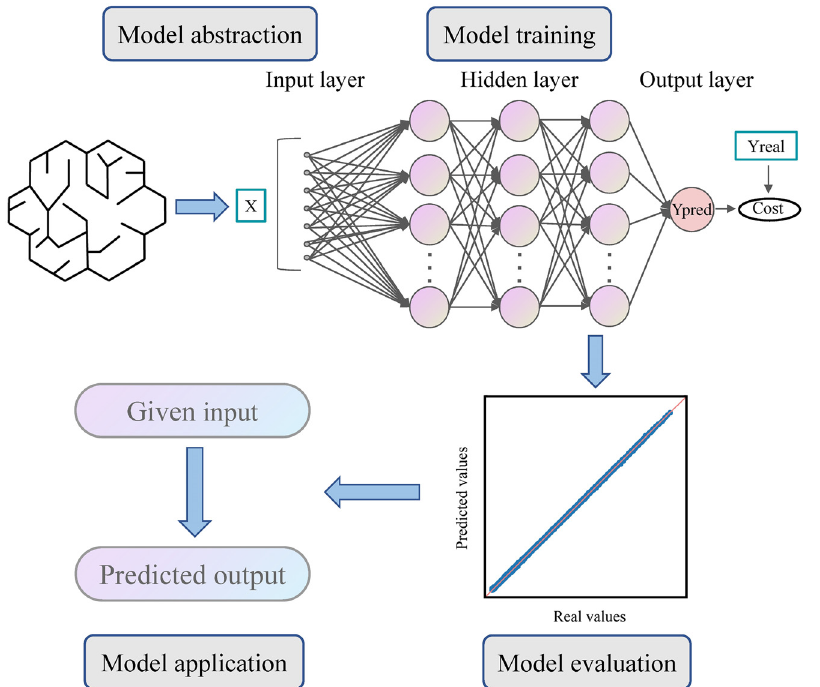
Figure 2: Working principle of artificial neuralnetworks.Theneuralnetworkmodel brain and consists of an input layer, a hidden layer and an output layer.